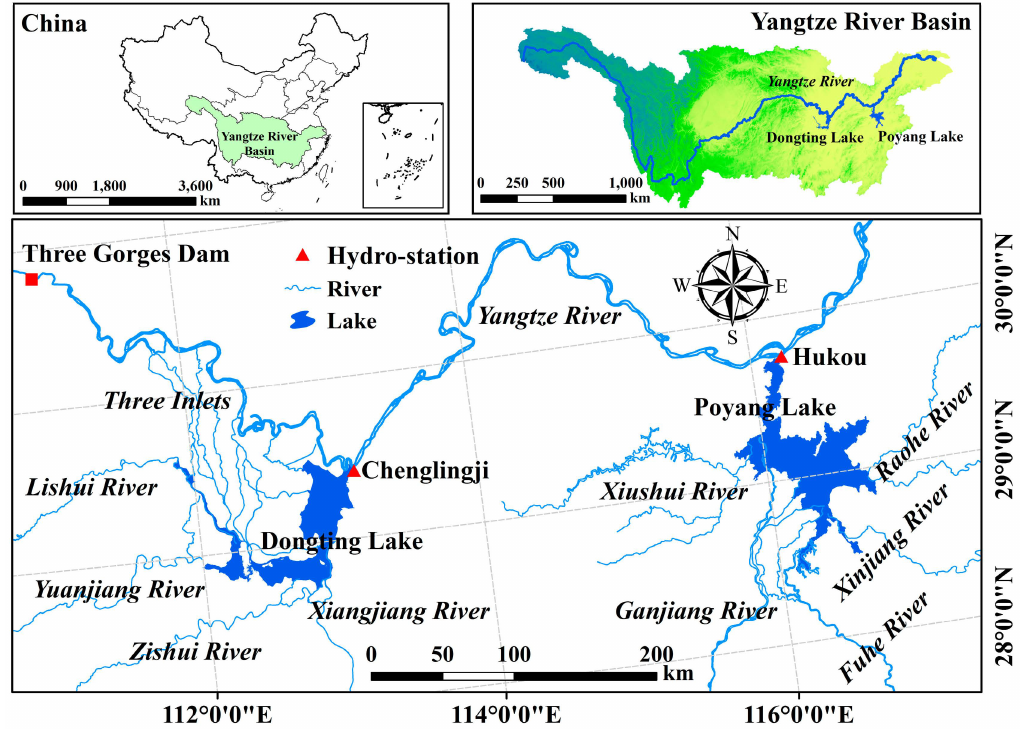
Figure 1. The river-lake system in the middle of Yangtze River basin with the two largest freshwater lakes, Dongting Lake and Poyang Lake, in China.